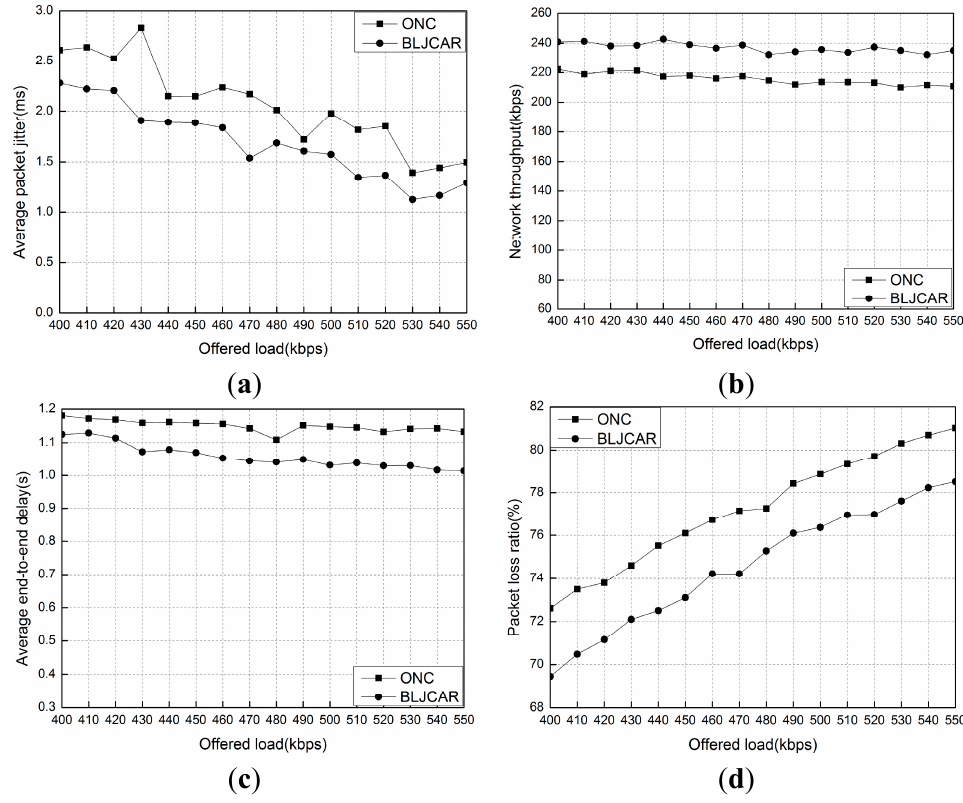
Figure 10. ( a ) Average packet jitter versus offered load; ( b ) Network throughput versus offered load; ( c ) Average end-to-end delay versus offered load; ( d ) Packet loss ratio versus offered